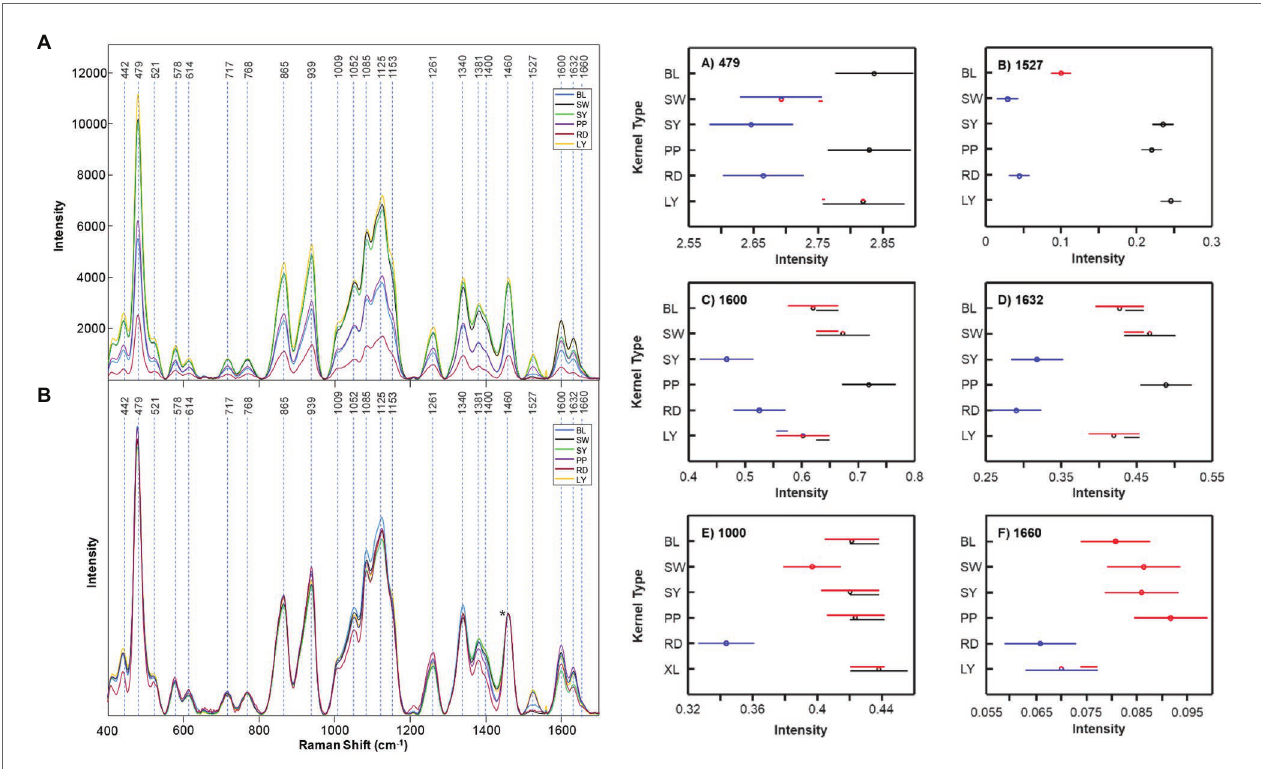
FIGURE 9 | Right: Raw (A) and normalized (B) Raman spectra of BL, SW, SY, PP, RD, and LY maize kernels. The 1,458 cm −1 peak, which was used for spectral normalization, is indicated by an asterisk (*). Left: Means (circles) and confidence intervals for the intensities of the maize kernel spectra, normalized to 1,458 cm −1 , at the indicated wavenumbers. Colors indicate significantly different groups. Multiple colors indicate a member of a group that has an overlap between two separate groups. Reproduced with permission from Krimmer et al.